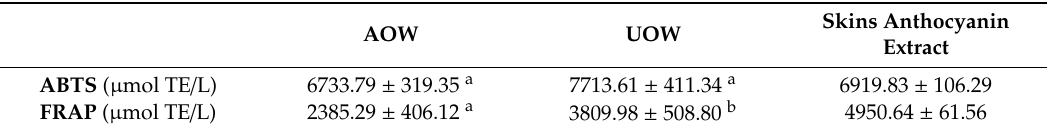
Table 2. Antioxidant activity of the oak phenolic extracts from American (AOW) and Ukrainian (UOW) shavings and of the skins anthocyanin extract from red